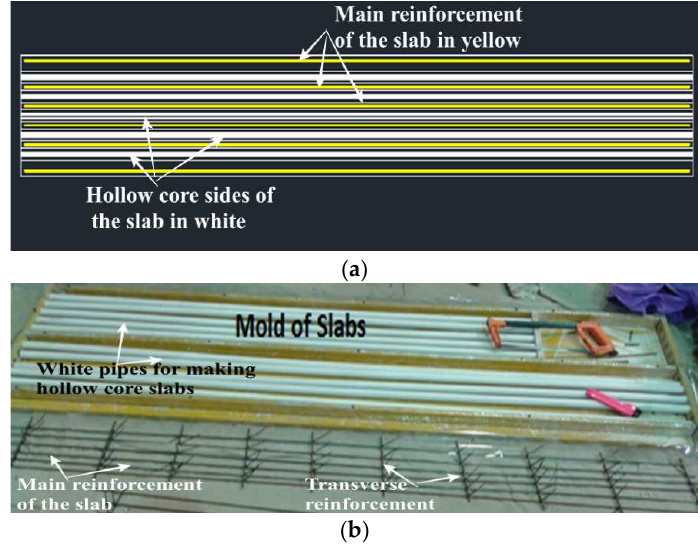
Figure 8. Details of slabs reinforcement: ( a ) AutoCAD drawing; ( b ) laboratory experiment.